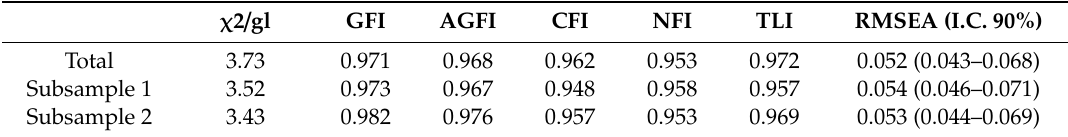
Table 3. AFC Goodness of fit indexes.